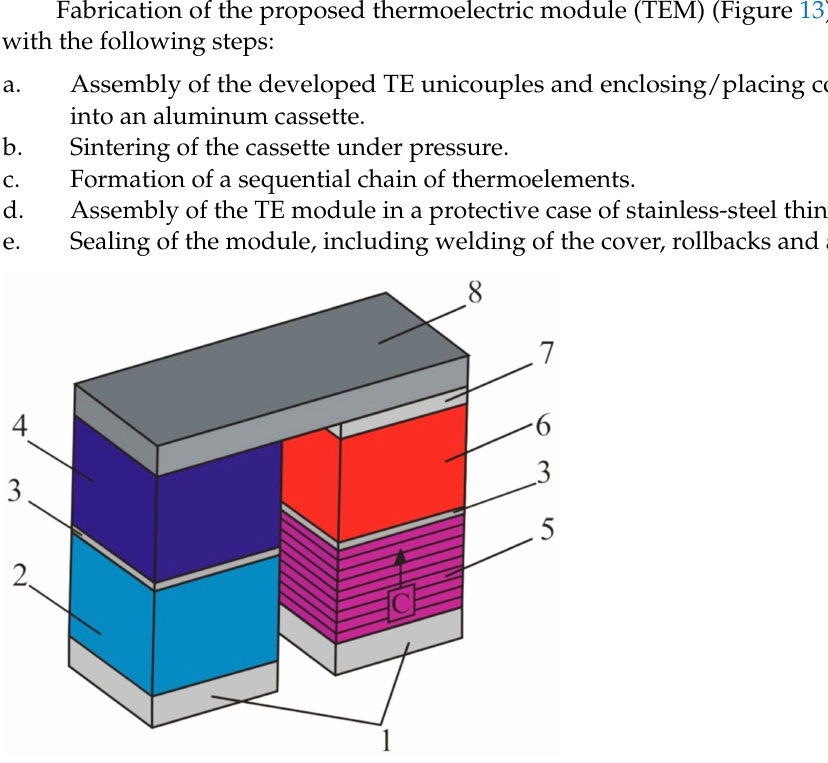
Figure 12. Design of multilayer thermoelectric generator unicouple (for the temperature range T c = 50 ◦ C and T h = 600 ◦ C); 1—metallic contact from Co + 6 wt% Bi. 2— n -type TE layer made by hot extrusion of n -Bi 2.7 Se 0.3 Te 3 . 3—thin Bi foil. 4— n -type TE layer made by SPS of n -Pb 0.999 InTe 0.999 I 0.001 .